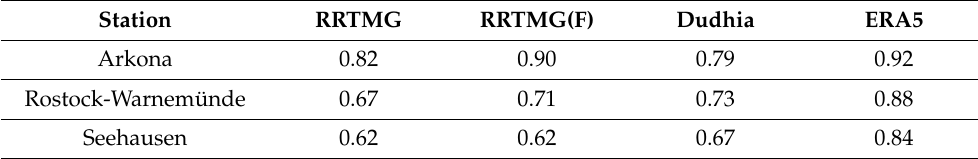
Table 4. Summary of correlation coefficients for warm